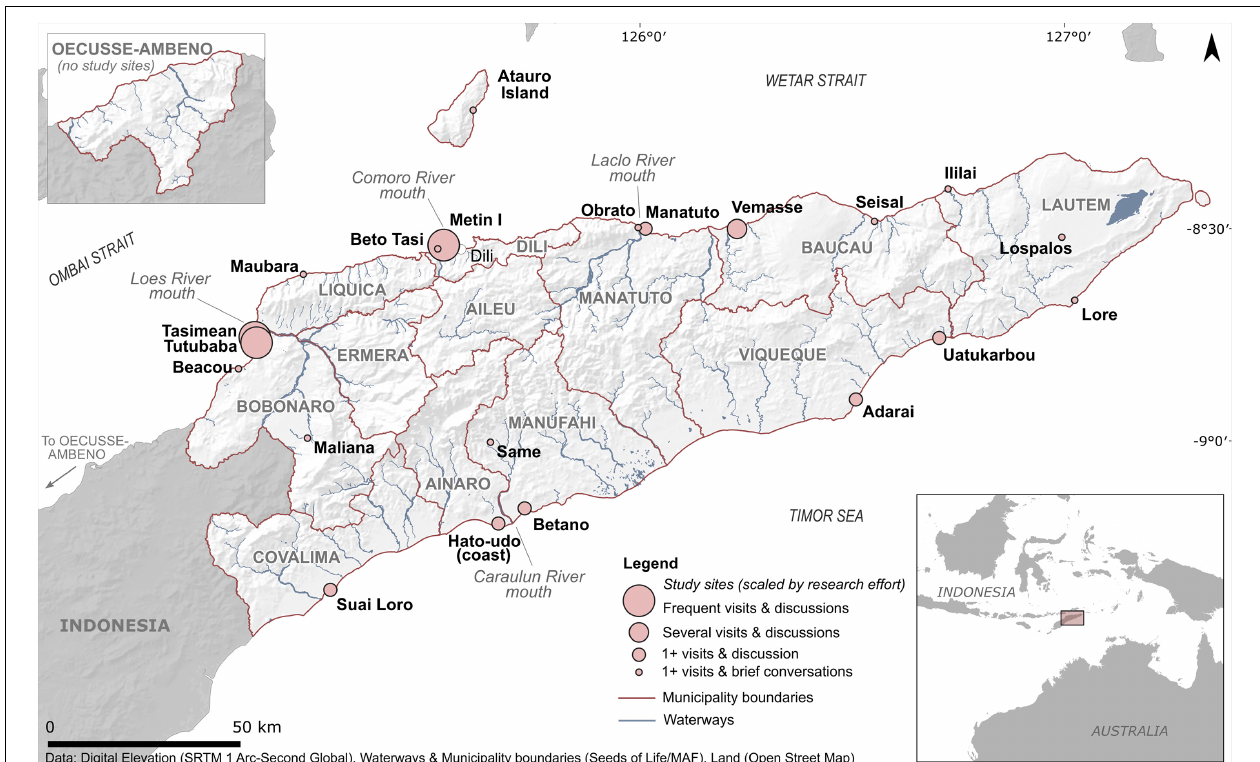
FIGURE 1 | Map of Timor-Leste, study sites and relative research effort.